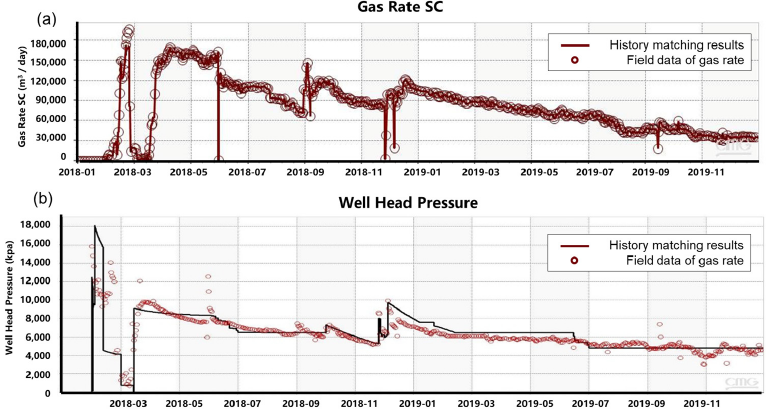
Figure 2. History matching results of ( a ) gas production and ( b ) wellhead pressure of Well #W2-A.